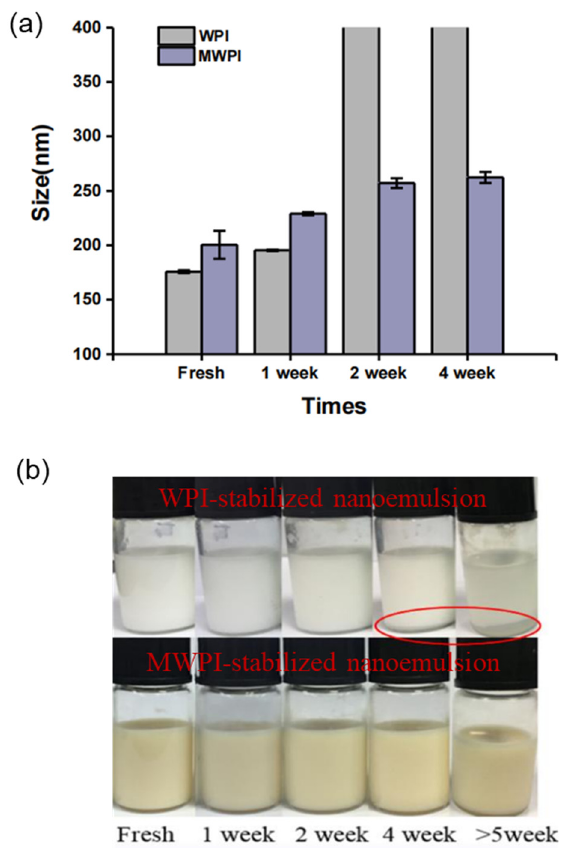
Figure 2. The particle size diagram ( a ) and appearance diagram ( b ) of nanoemulsions prepared with WPI and MWPI as emulsifiers over time.